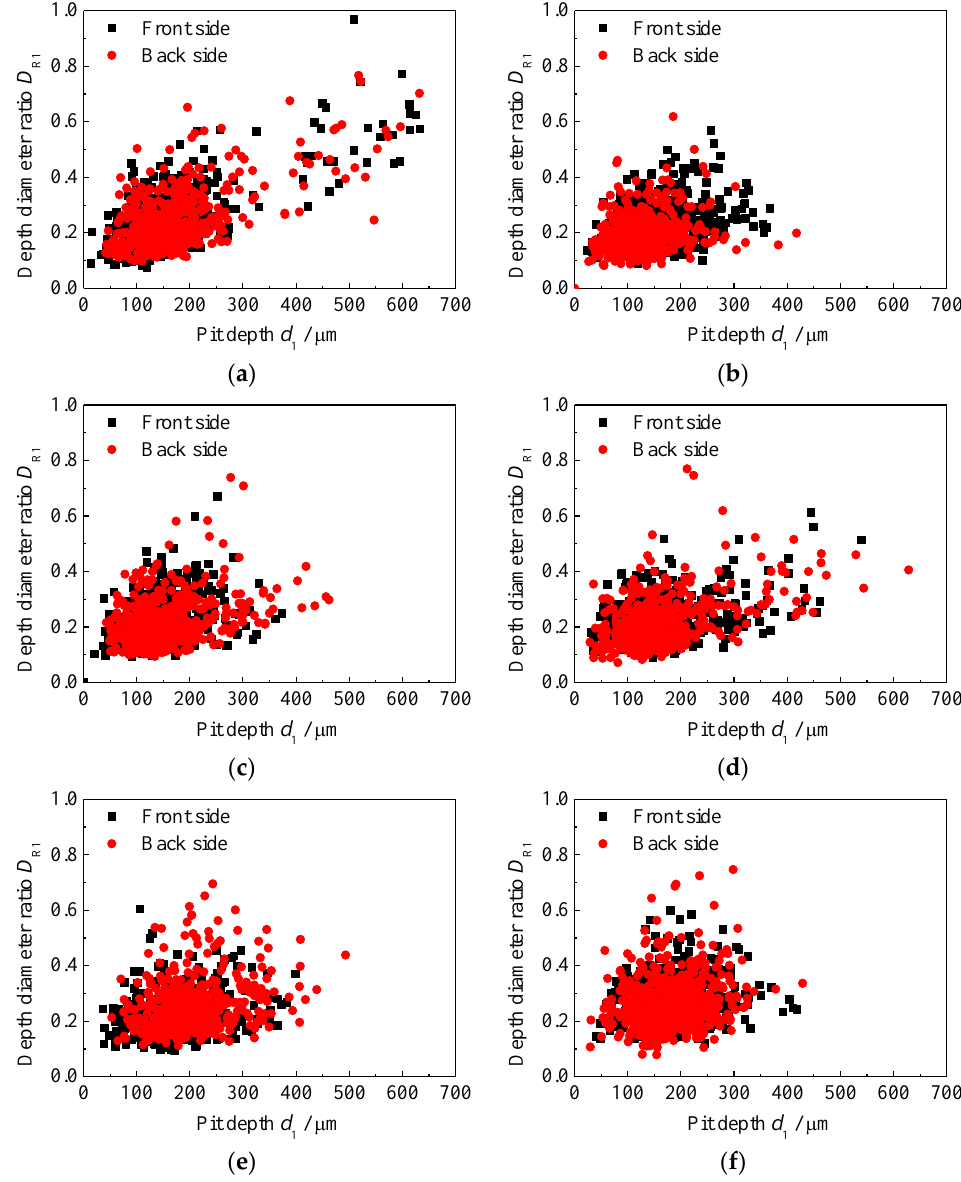
Figure 9. Depth diameter ratio D R1 versus rust pit depth d 1 for corroded steel plates with different corrosion durations: ( a ) C3, ( b ) C4, ( c ) C6, ( d ) C8, ( e ) C12, ( f ) C15.